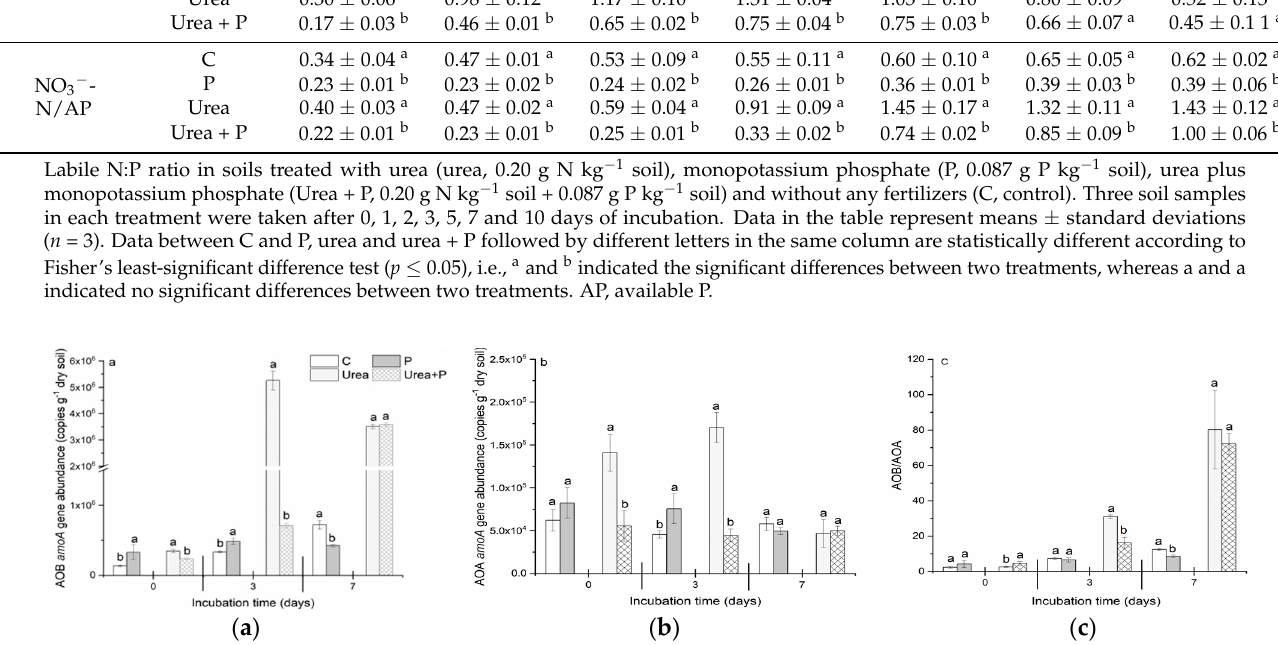
Figure 3. Changes of amoA gene abundance of AOB ( a ), AOA ( b ) and ratio of AOB to AOA ( c ) in soil amended with and without urea, P, and urea + P during incubation period. Legends correspond to the amendment of urea N (urea, 0.20 g N kg − 1 soil), monopotassium phosphate (P, 0.087 g P kg − 1 soil), urea N and monopotassium phosphate (urea + P, 0.20 g N kg − 1 soil + 0.087 g P kg − 1 soil). The soil without nitrogen and phosphorus addition was used as the control (C, control). Three soil samples in each treatment were taken after 0, 3, 7 days of incubation. Data in the figure represent means ± standard deviations ( n = 3). Different letters on the column between the treatment of C and P, Urea and Urea + P at the same sampling period indicate statistical difference according to Fisher’s least-significant difference test ( p ≤ 0.05).